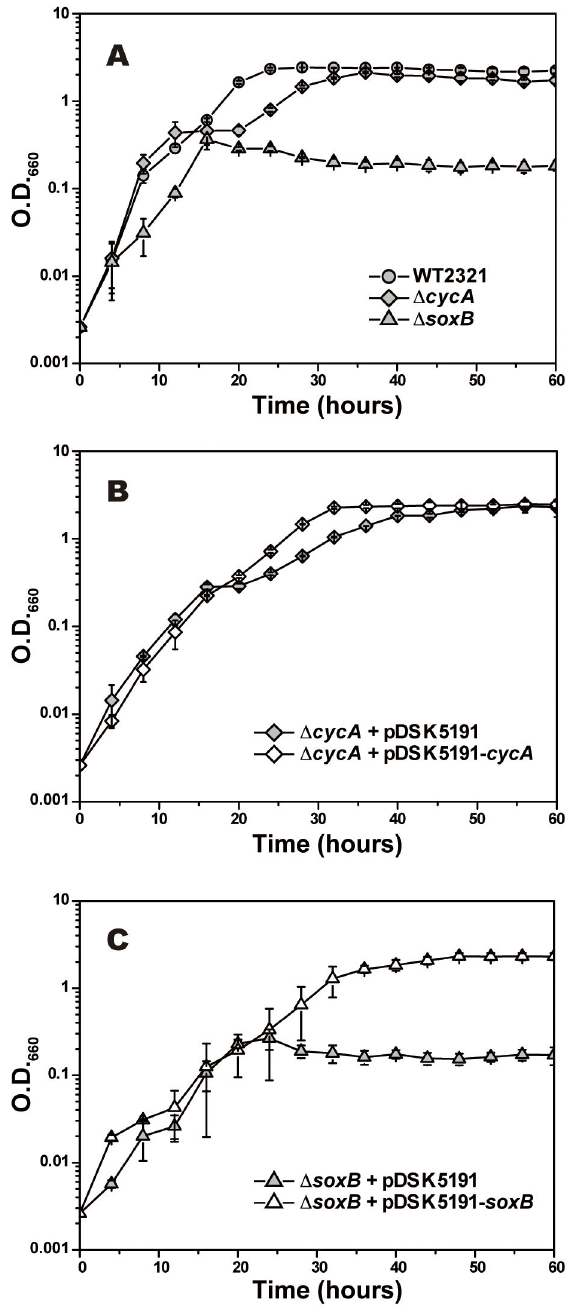
Figure 3. Growth curves of C. tepidum mutants after gene complementation experiments. Growth curves of C. tepidum mutants used as host strains (A), transconjugant strains of ∆ cycA mutant (B), and ∆ soxB mutant (C). Each strain was grown in a liquid CL medium at 40°C (for details, see Materials and Methods), and its optical density (O.D.) was monitored at 660 nm. In the transconjugant cultures, 1 µg/mL of Em was added for the stable maintenance of plasmids. The average values and standard deviations, which were obtained from at least three independent experiments, were plotted. doi: